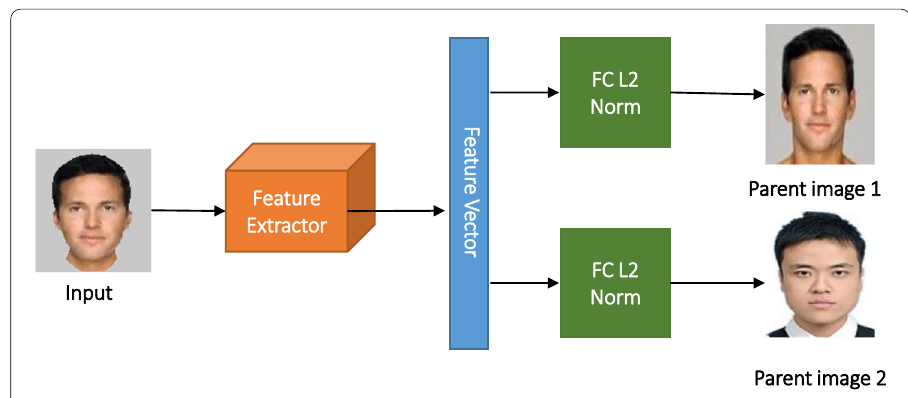
Fig. 9 MFR‑Net V2 architecture diagram